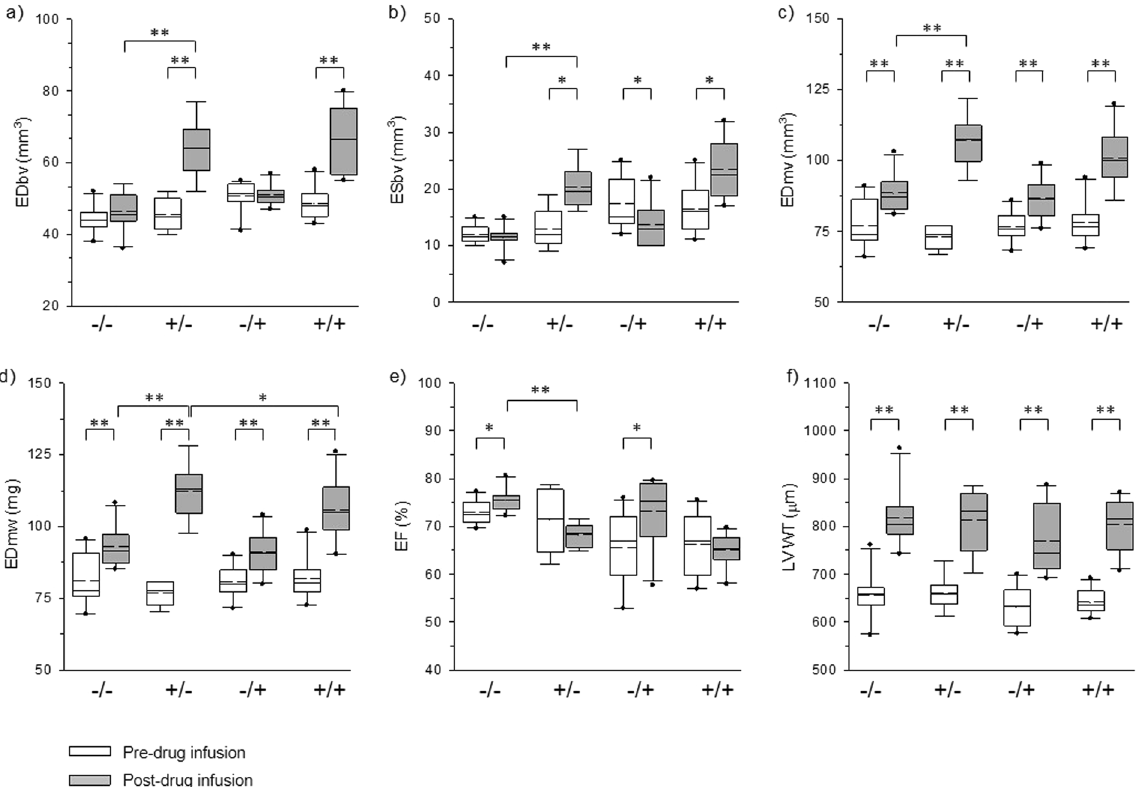
Figure 3. Graphs displaying the cardiac function and anatomy-indicating factors measuring from the cardiac CINE-MRI ( a ) EDbv, ( b ) ESbv, ( c ) EDmv, ( d ) EDmw, ( e ) EF of LV, ( f ) LVWT. − / − : saline group, + / − : AngII group, − / + : sRAGE group, + / + , AngII + sRAGE group. Straight line: median value, dashed line: mean value, * p < 0.05, ** p <